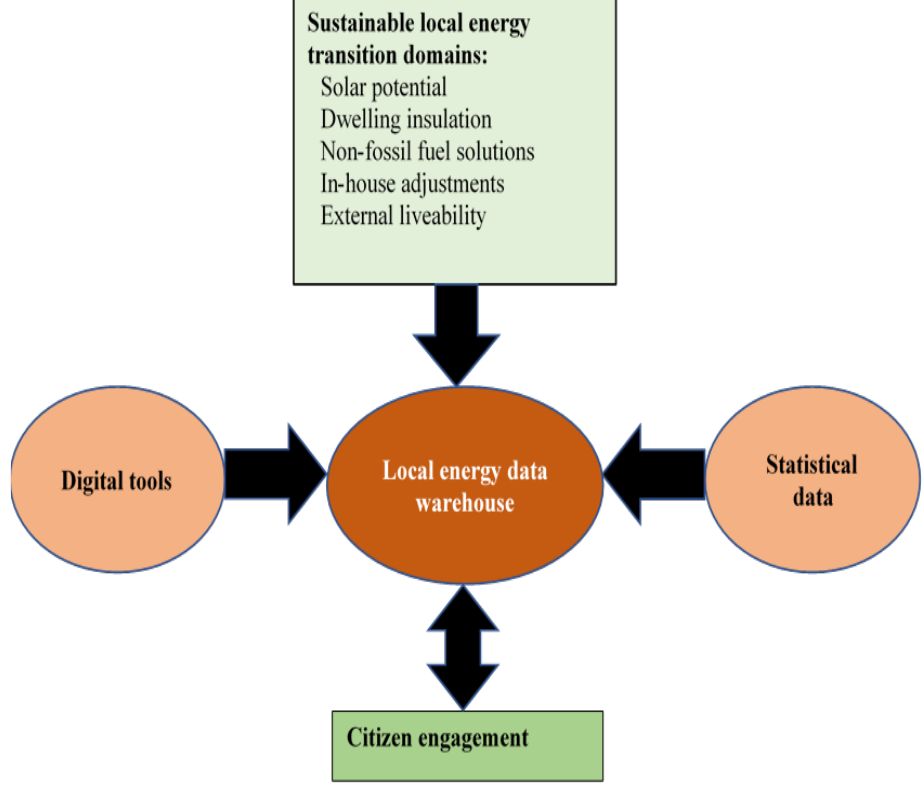
Figure 2. Data support framework for local energy transition.